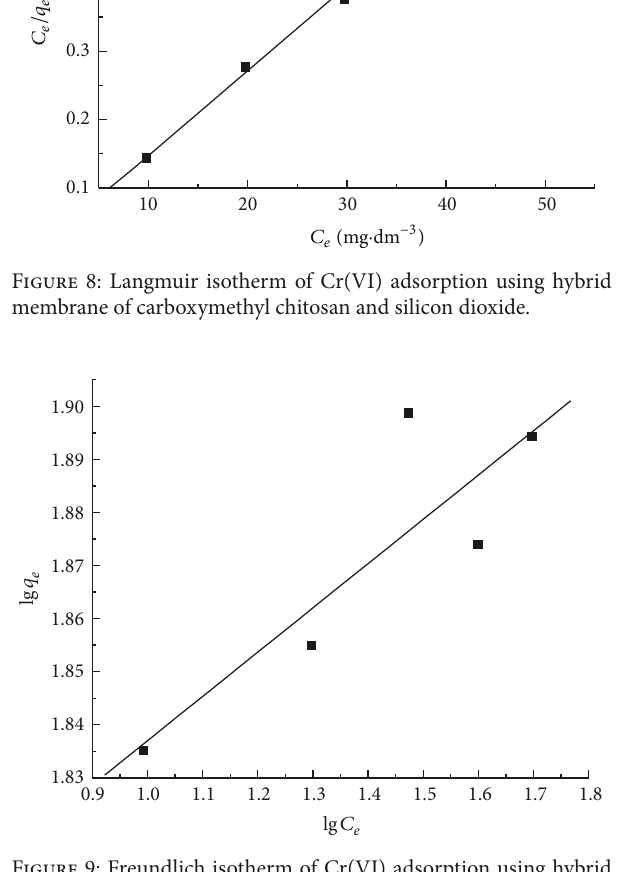
Figure 9: Freundlich isotherm of Cr(VI) adsorption using hybrid membrane of carboxymethyl chitosan and silicon